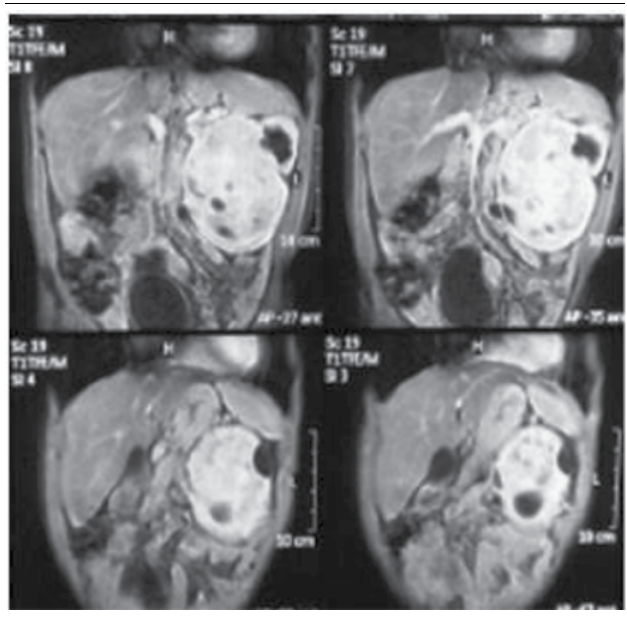
figurE 1 – Computer tomography of abdomen showing large mass in the left kidney The hypothesis of a malignant renal neoplasm was questioned, and based on this conjecture we choose to perform radical left nephrectomy by subcostal approach and lymphadenoctomy. The surgery occurred without complications.